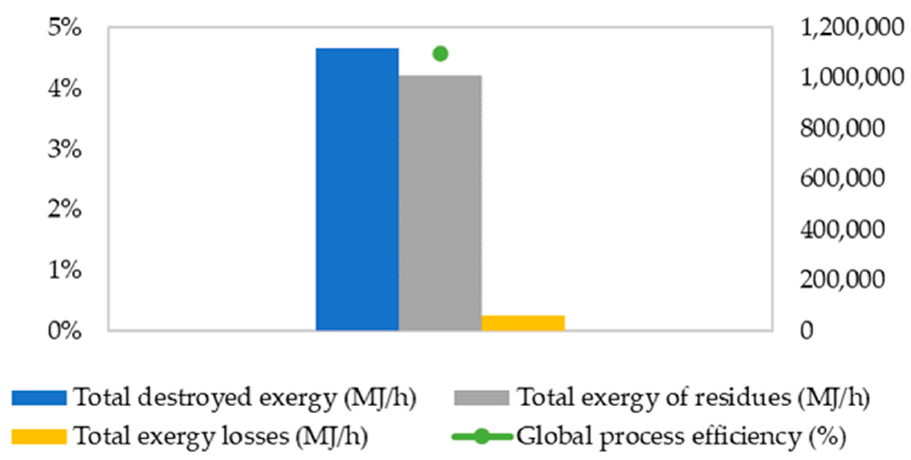
Figure 9. Global exergy results for chitosan production from shrimp exoskeleton. Adapted from: [13].